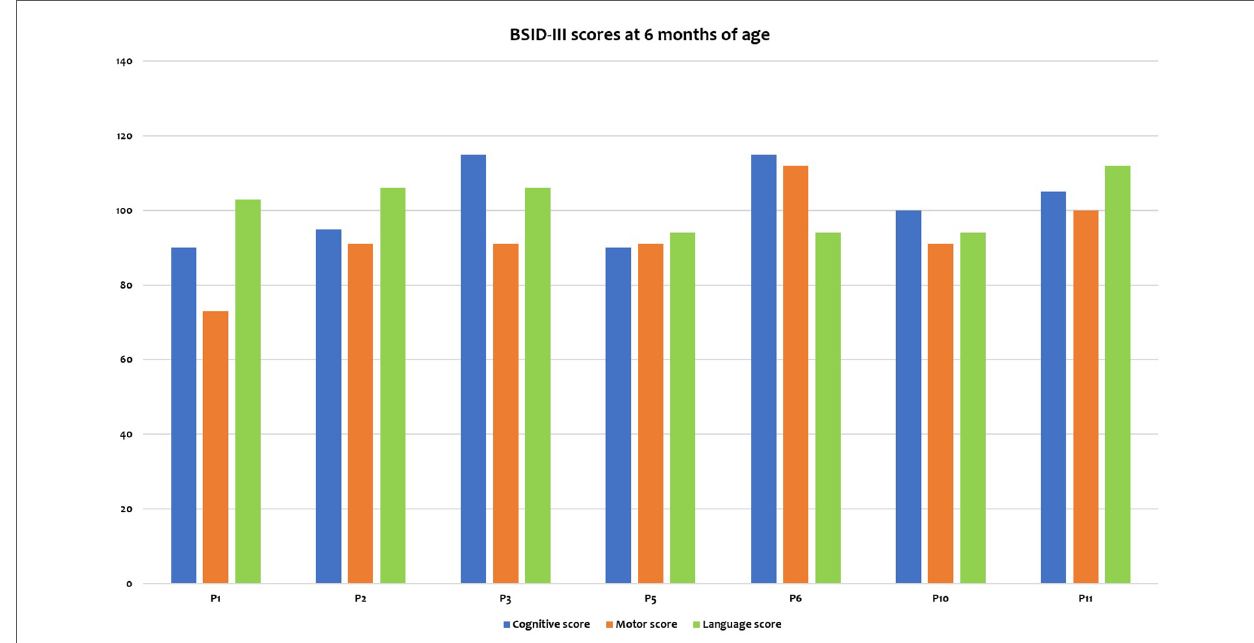
FIGURE 3 Short-term neurodevelopmental outcomes at 6 months of